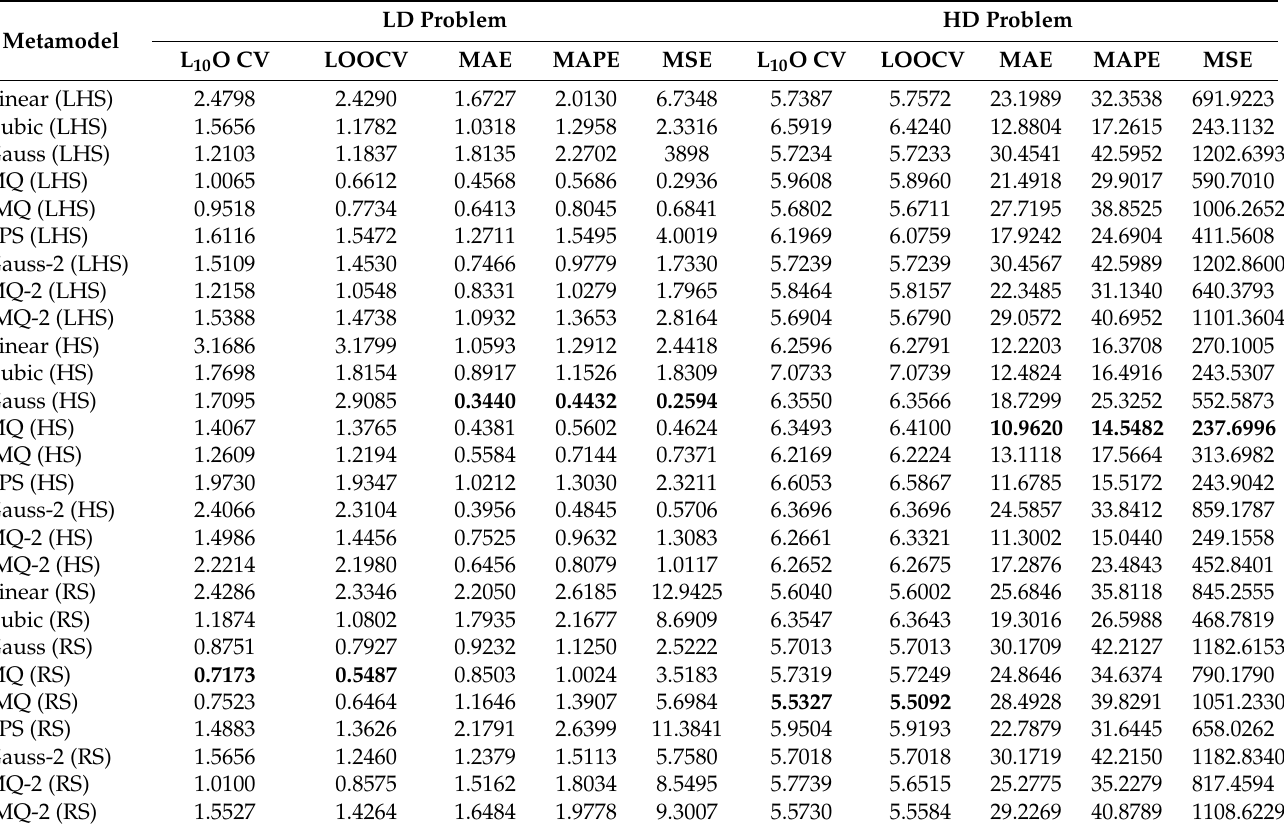
Table A2. Comparison of all metamodels based on various metrics for second frequency.